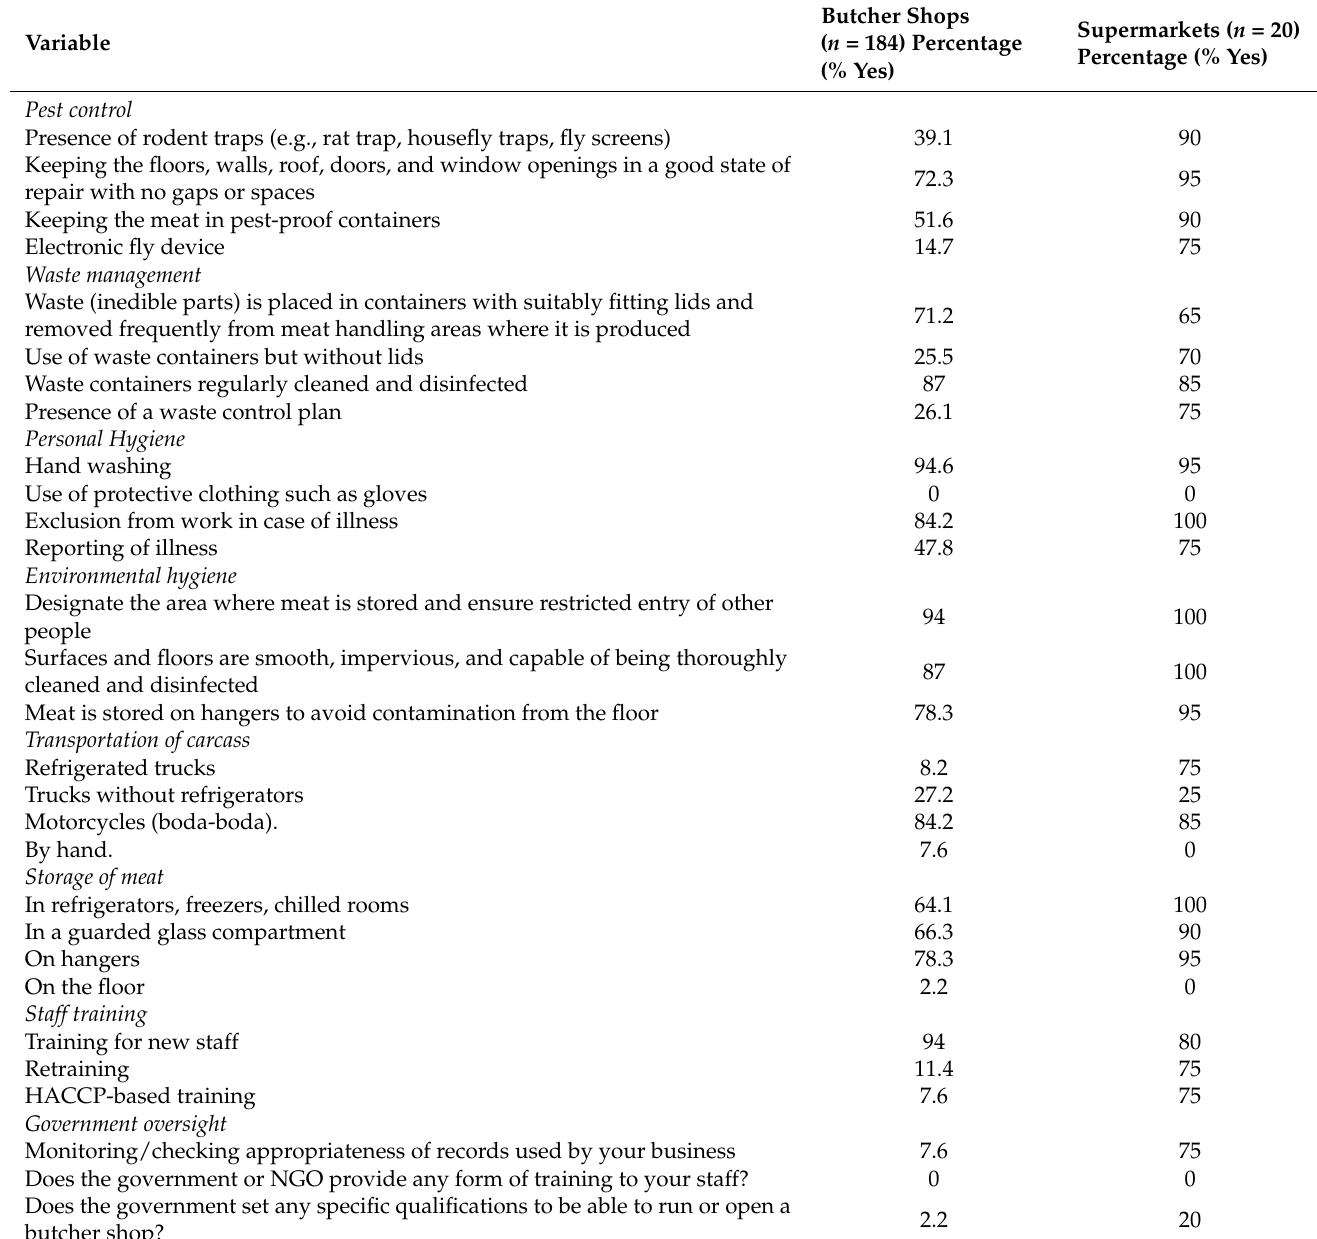
Table 4. Assessment of hygiene practices carried by the butcher shops and